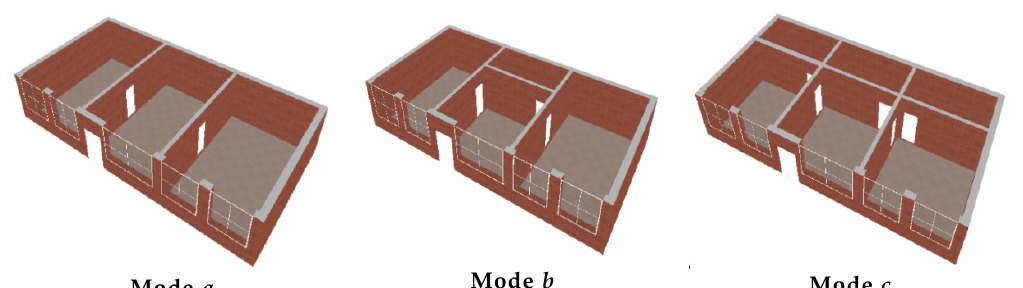
Figure 9. Building numerical models.